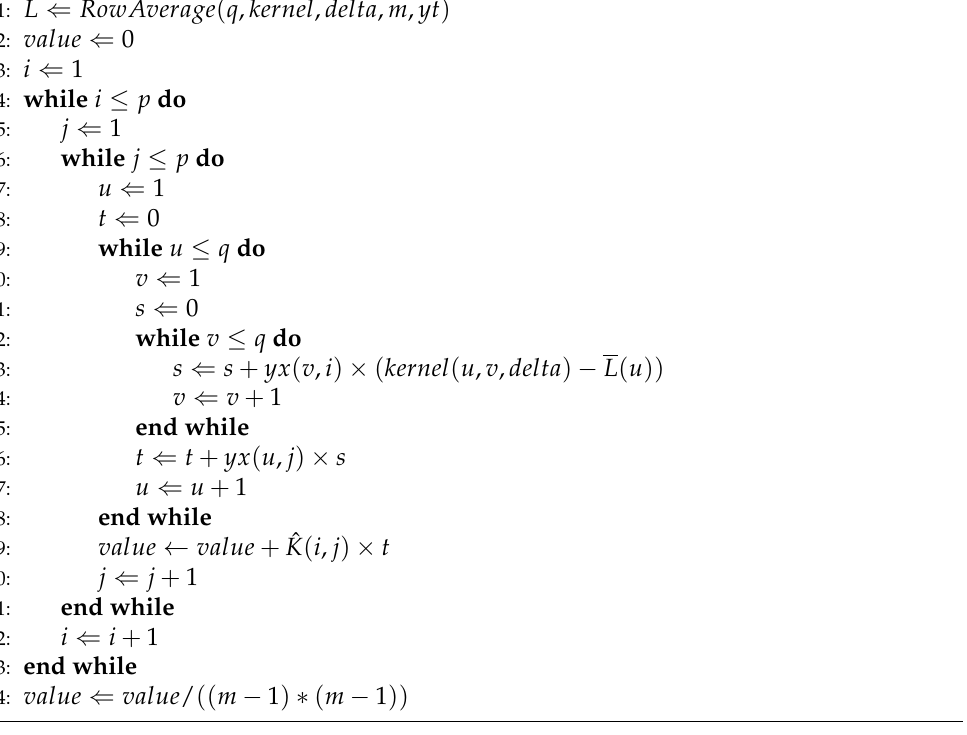
Algorithm 4 Calculate value = Trace ( ˆ K , yt , yx , p , q , kernel , delta , m )